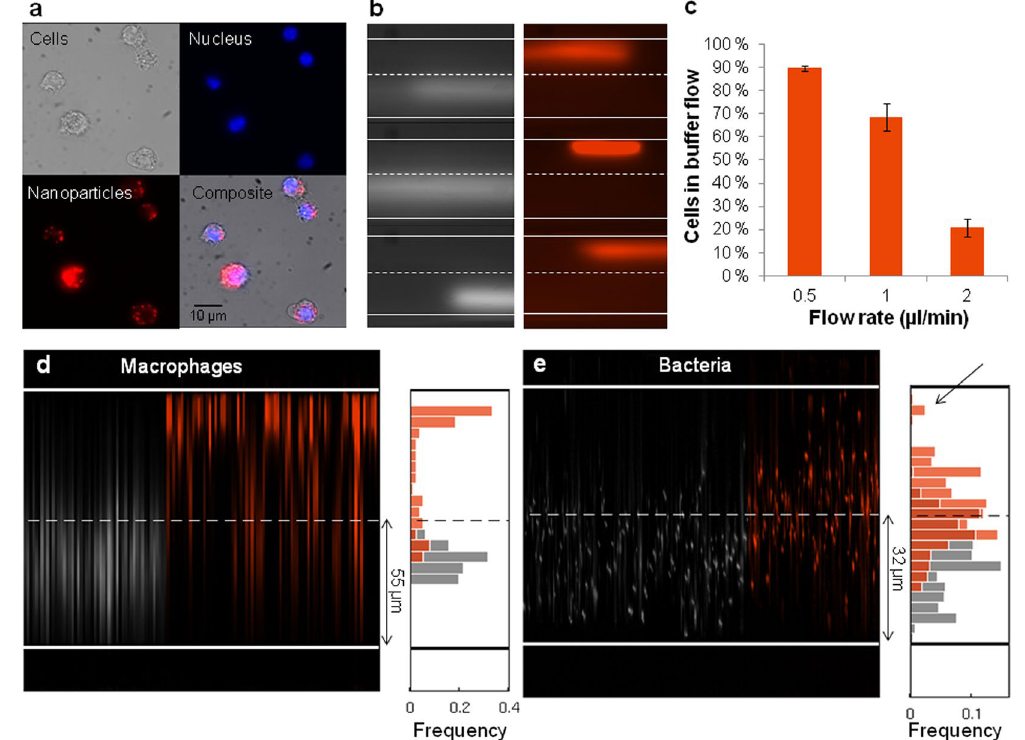
Figure 3. Separation of cells with intrinsic magnetic properties in the microfluidic device. ( a ) Macrophages containing phagocytosed nanoparticles (100 nm with 30 nm magnetic cores; red) were labeled with a nuclear stain (blue) for visualization in the sorting channel. ( b ) Examples of cells in the sorting channel without (gray) and with (orange) the external NdFeB magnet at a sample flow rate of 1 µ l/min, observed at the center of the sorting channel. ( c ) Sorting efficiency of macrophages at different sample flow rates. The bar graph represents the average number of cells in the buffer flow with the external magnet. Error bars indicate SEM over multiple placements of the magnet (trials). ( d ) Example of data analysis for one trial of macrophages without (gray) and with (orange) the permanent magnet present. ( e ) Magnetotactic bacteria were sorted in a smaller device optimized for the smaller size of the prokaryotic cells. The histograms combines data from three trials and show a shift of the flow of bacteria in the presence (orange) of the external magnet compared to without the magnet (gray). The fraction of bacteria with highest magnetic moments was observed close to the wall